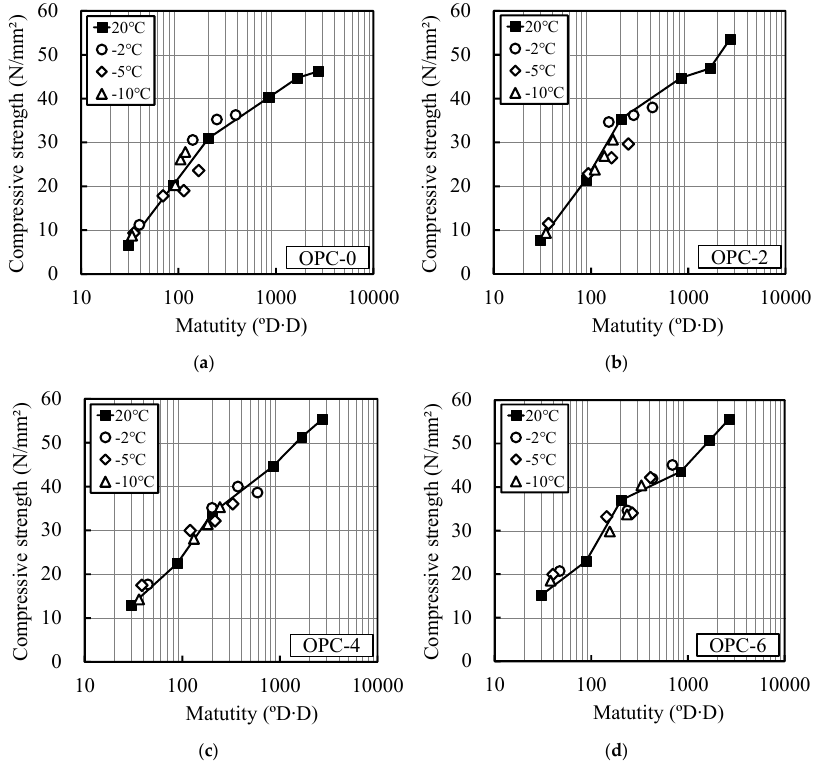
Figure 9. Relation between maturity and compressive strength (OPC): Proposal equation for this study, ( a ) OPC-0; ( b ) OPC-2; ( c ) OPC-4; ( d ) OPC-6.